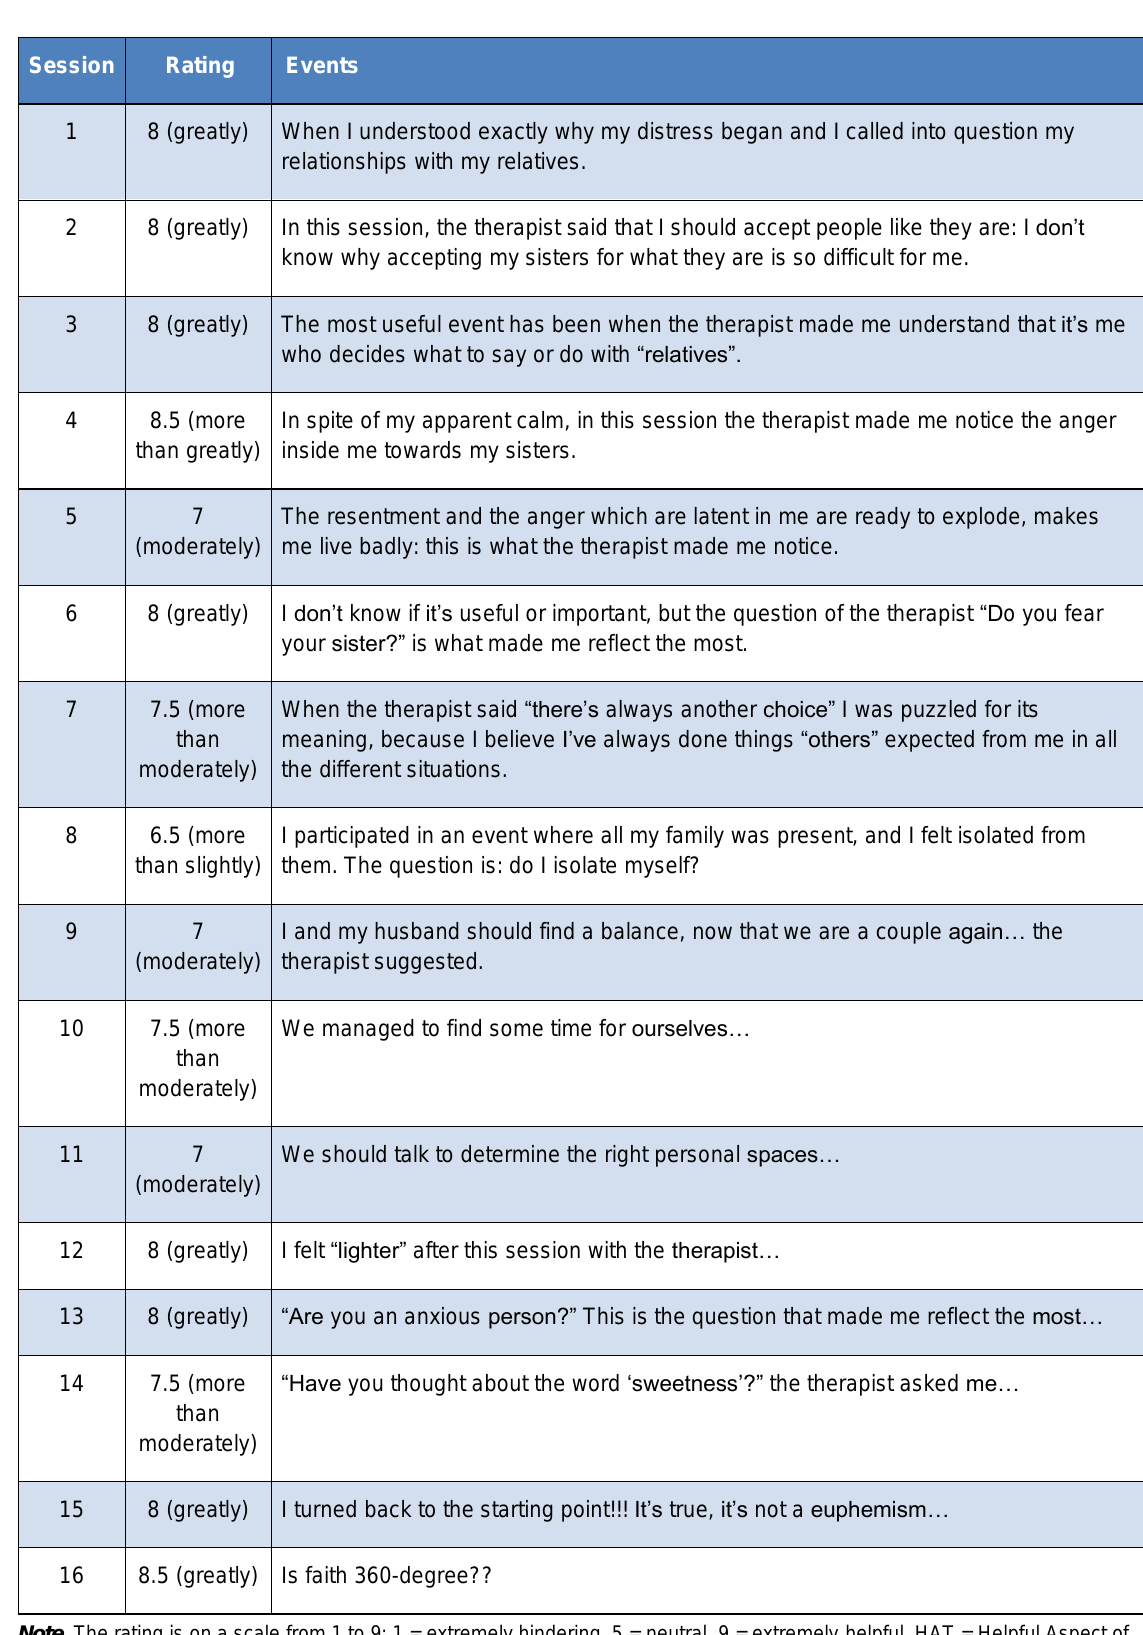
Table 4: Margherita’s helpful aspect of therapy (HAT forms) (Short